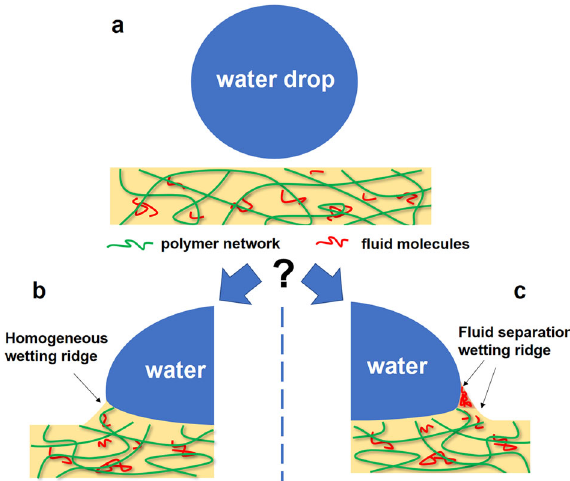
Fig. 1 Schematic illustration of possible outcomes for soft wetting on a swollen network. a Prior to drop deposition, the surface is homogeneous and fl at. b , c Schematic of two possible wetting ridges upon placing a water drop on the surface: ( b ) a homogeneous ridge and ( c ) a fl uid separating